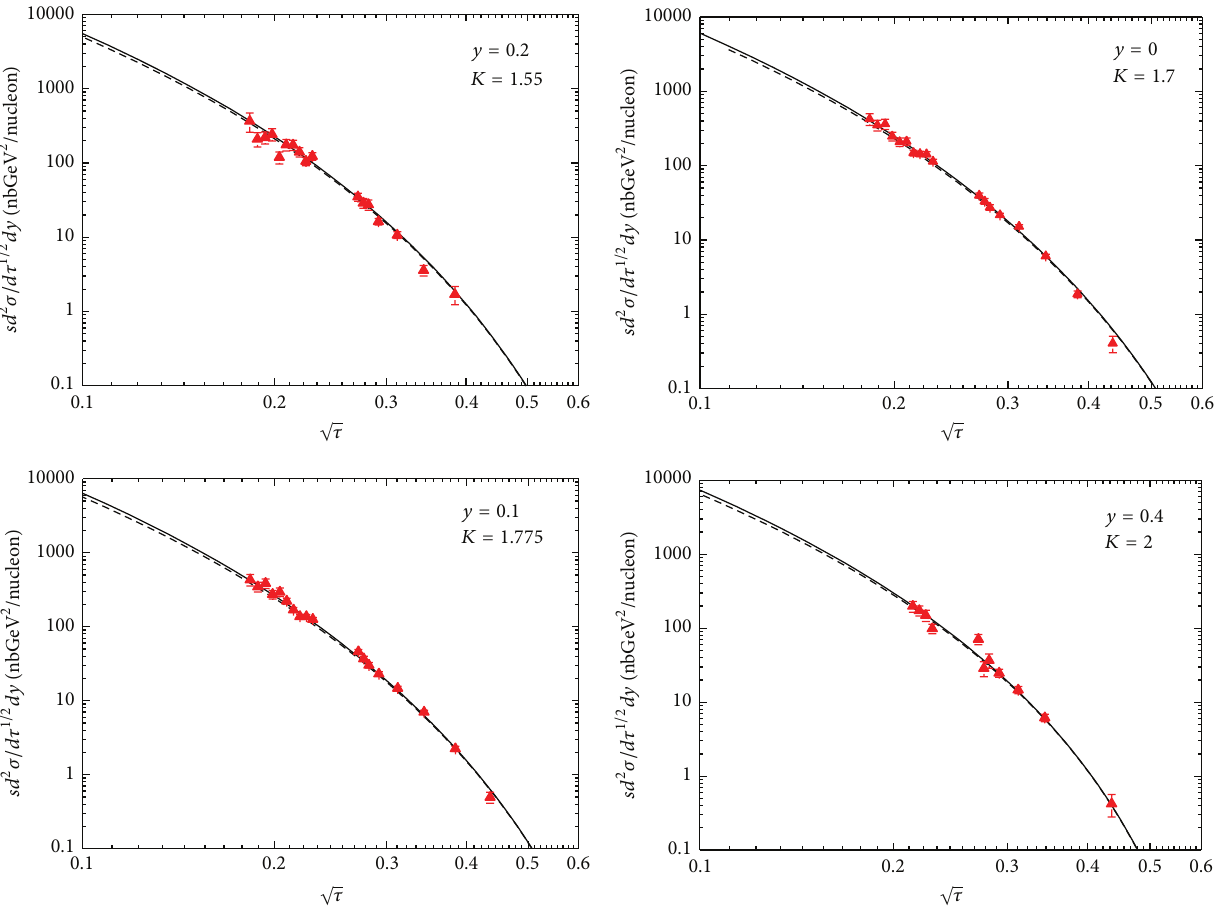
Figure 9: Dileptons production cross section for p-Cu collision in terms of √𝜏 according to (13) for 𝑦 = −0.2 , 0, 0.1, and 0.4 and √ 𝑠 = 38.8 GeV. The full curve is obtained by considering the pionic contribution and the dashed line is plotted without considering the pionic contribution. The used 𝐾 factor has been indicated in each graph. The difference between full and dashed lines is about 3–8%. The experimental results have been taken from